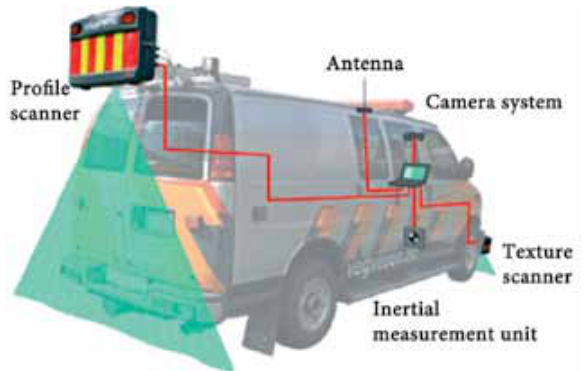
Fig. 1. Typical components of a ViaTech ViaPPS